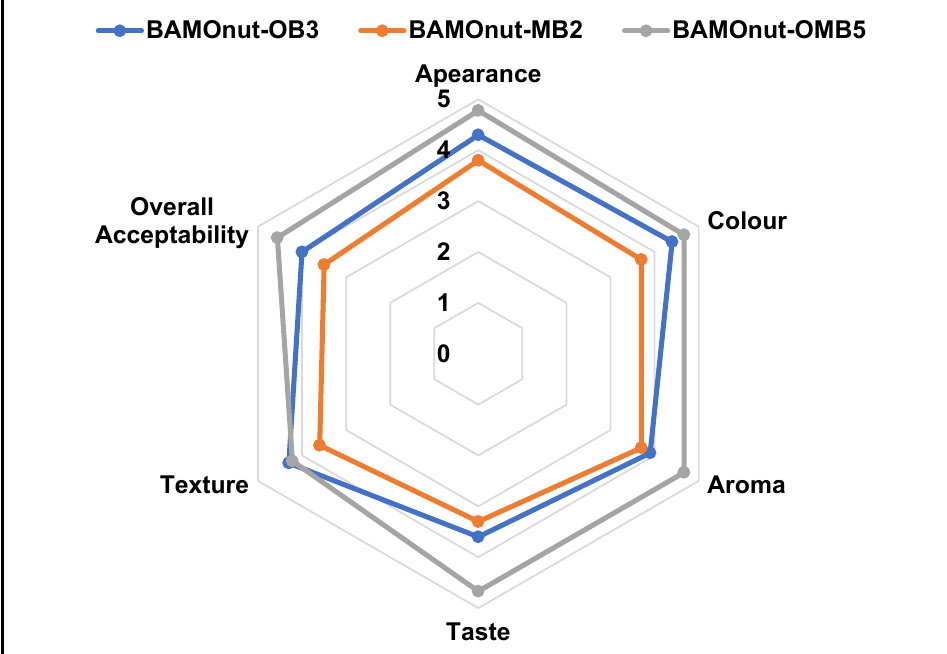
Figure 6. Spider plot showing sensory scores for Bambara groundnut– Moringa oleifera snack bars (BAMOnut). Two of the BAMOnut snack bars (BAMOnut-OB3 and BAMOnut-OMB5) were not significantly different for appearance, colour, and aroma, but both were significantly ( p < 0.05) different to BAMOnut-MB2. The appearances of BAMOnut-OB3 and BAMOnut-OMB5 (4.30, 4.78) were judged significantly ( p < 0.05) higher compared to that of BAMOnut-MB2 (3.80). The colours of BAMOnut-OB3 and BAMOnut-OMB5 (4.40, 4.67) scored significantly ( p < 0.05) higher in comparison to BAMOnut-MB2 (3.70). The panellists described the colour of BAMOnut-MB2 as very dark. The aroma of BAMOnut-OB3 and BAMOnut-OMB5 (3.90), (4.67) were rated significantly ( p < 0.05) higher compared to that of BAMOnut-MB2 (3.70). The bar (BAMOnut-MB2) that included millet and 2% BAMOLP had lower ratings for appearance, colour, and aroma due to the high concentration (80 g) of MOLP used in the formulation. A similar observation was reported by [27] for MOLP supplementation in wheat